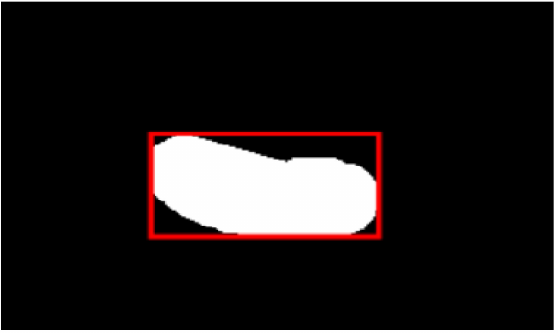
Figure 5. Construction of a rectangular area containing tumor